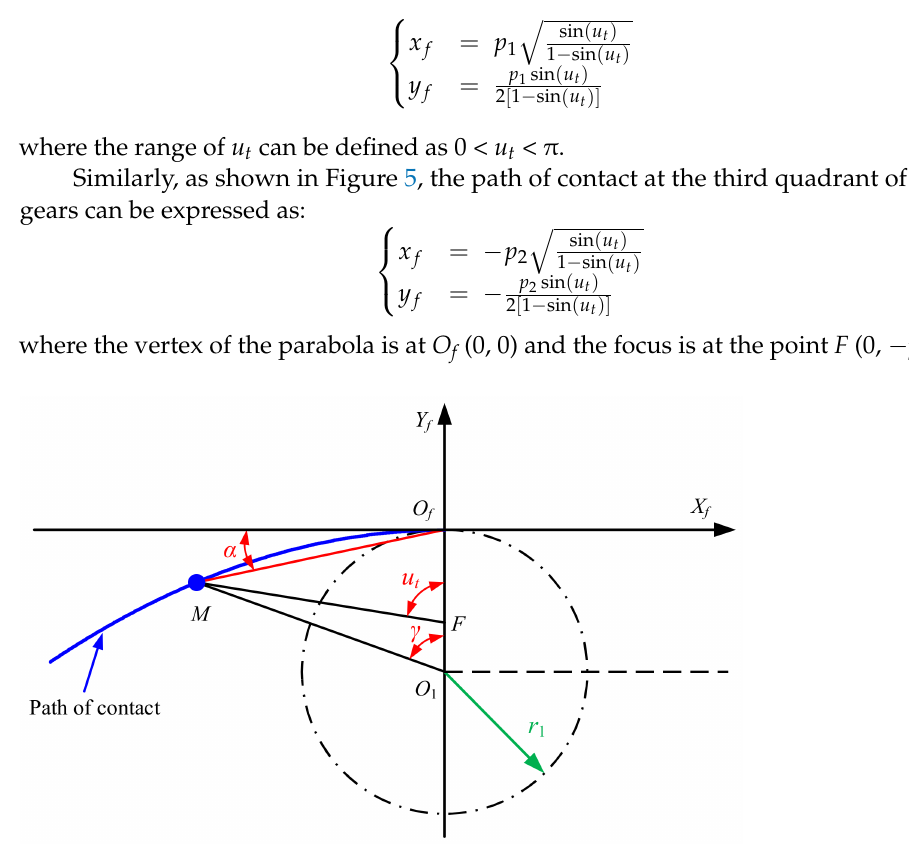
Figure 5. Parabolic path of contact at the third